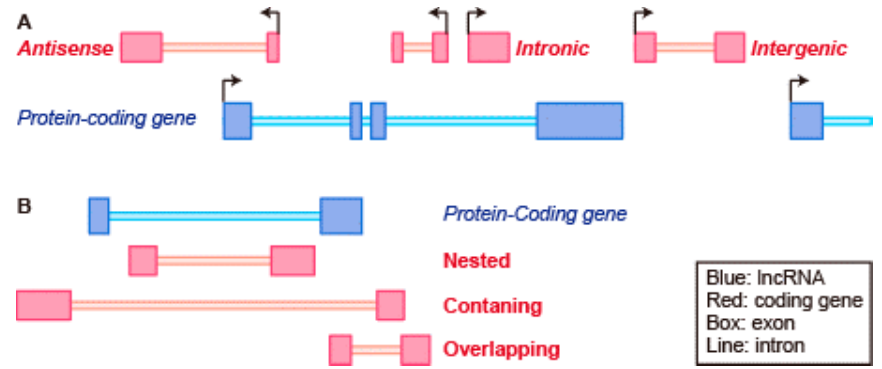
Figure 1. Genomic organization of coding and non-coding transcripts. ( A ) Schematic representation of the types of long non-coding transcripts (pink) that are associated with coding genes (blue). Antisense lncRNAs are transcribed from the opposite strand of protein-coding genes with which they share sequence complementarity. Intronic lncRNAs contain within protein-coding loci partly or completely. Intergenic lncRNAs do not intersect with any protein-coding genes. ( B ) Intronic lncRNA subtypes by their relationship with respect to the nearest protein-coding gene. Nested lncRNAs contained entirely within protein-coding transcripts. Containing lncRNAs are contained Protein-coding transcripts completely. Overlapped lncRNAs are neither ‘nested’ nor ‘containing’. Dark-colored box, exon; Light-colored bar, intron.